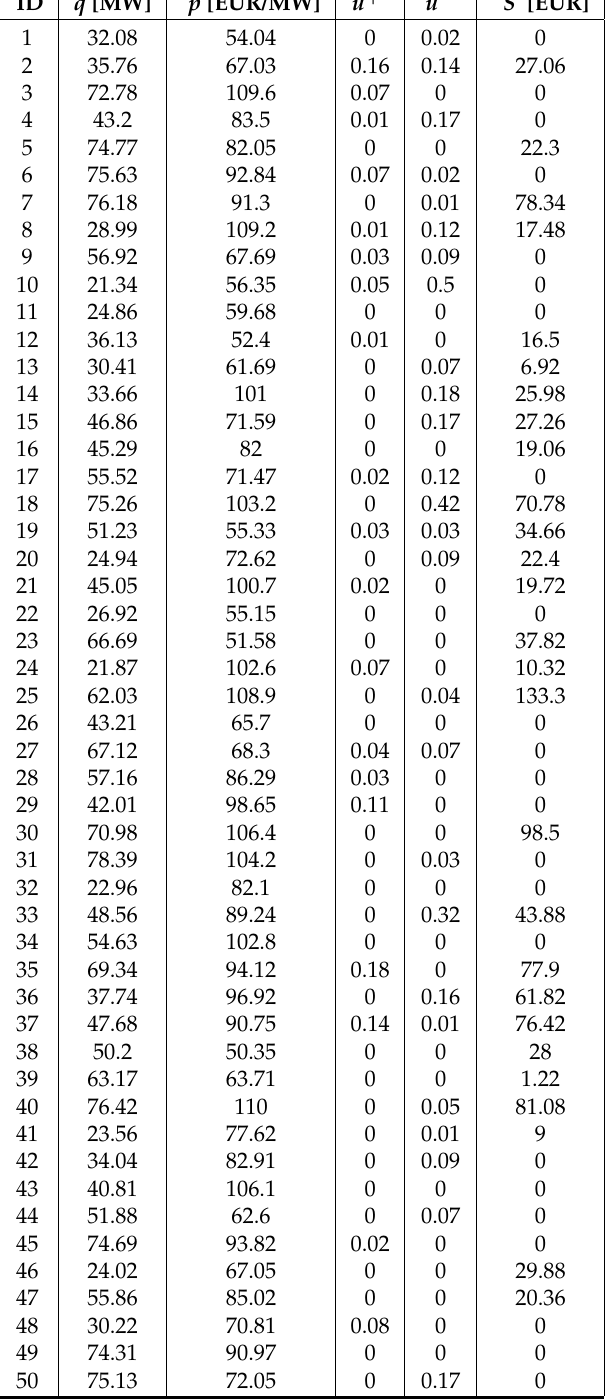
Table A2. Reference ES bid set: The columns correspond to the index of the bid (ID), quantity ( q ), bid price ( p ), positive and negative uncertainty ( u + , u − ), and S